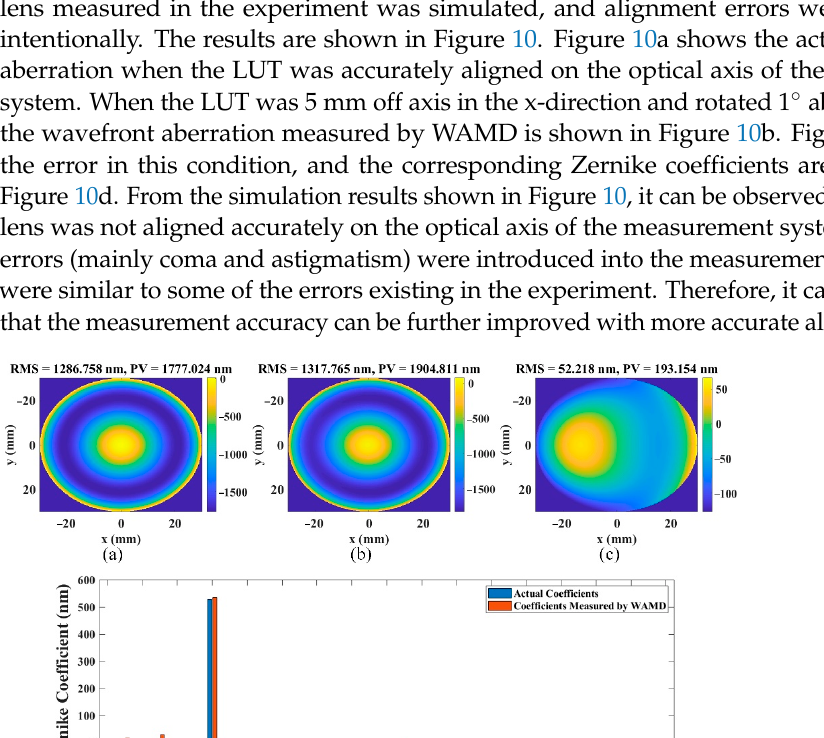
Figure 9. Wavefront aberration of the telephoto lens in the experiment: ( a ) measured by WAMD; ( b ) measured by a Zygo interferometer; ( c ) difference between ( a , b ); ( d ) comparison of Zernike coefficients.